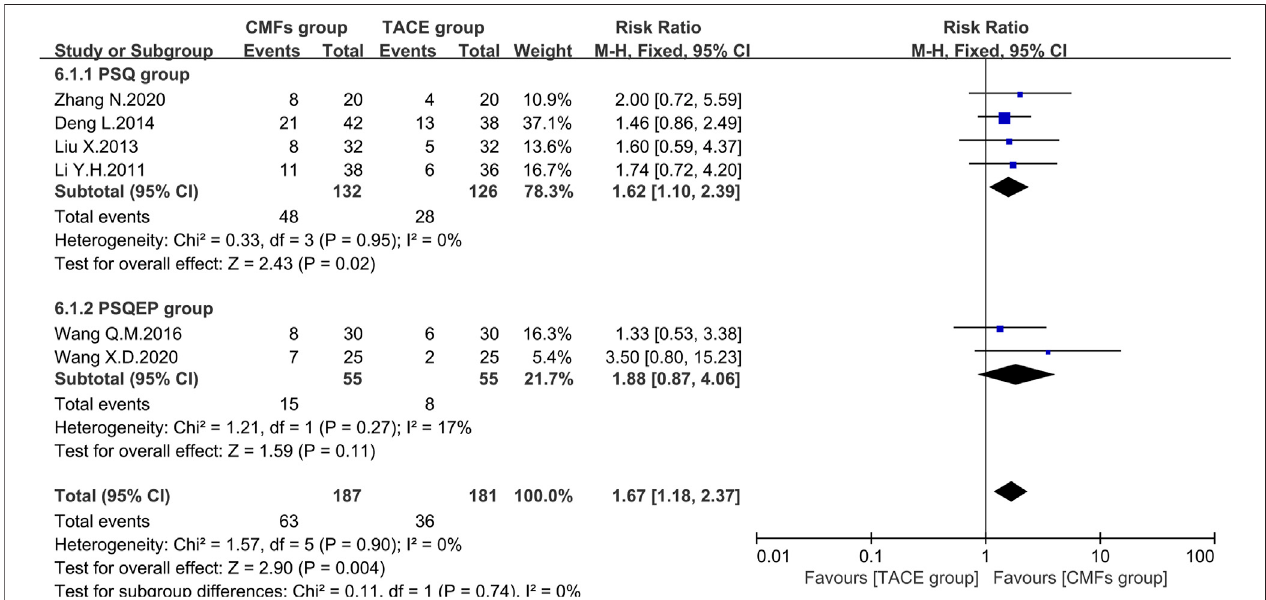
FIGURE 13 | Effect of CMFs group versus TACE group on the improvement of symptoms, including a comparison between PSSQ and PCSQEP in the subgroup.